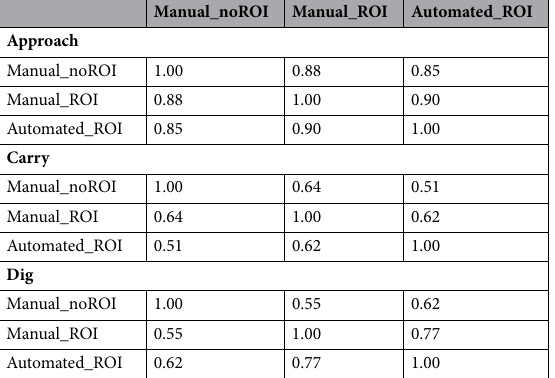
Table 3. Correlational matrices of maternal approach, carry and digging behaviors scored with three different methods: manual with no defined ROI, manual with defined ROI and automated scoring with